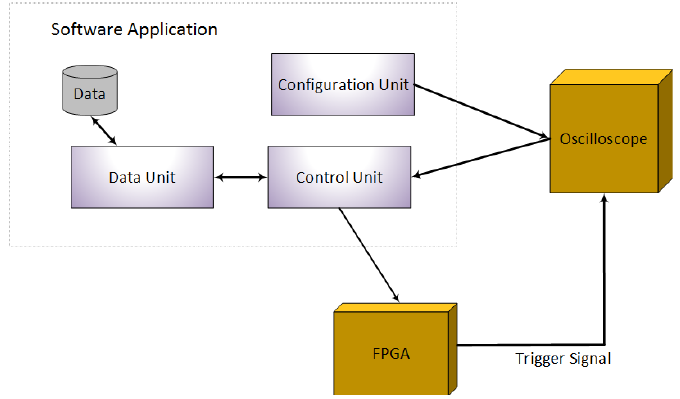
Figure 7. GUI for raw Sample Collection Application and hardware setup for power analysis data capture.